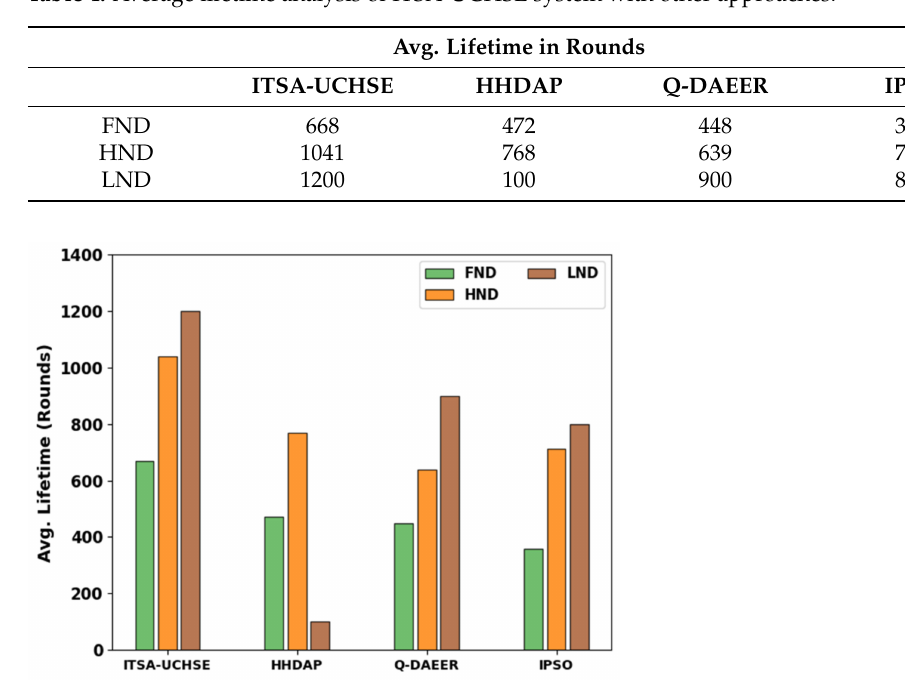
Table 4. Average lifetime analysis of ITSA-UCHSE system with other approaches.